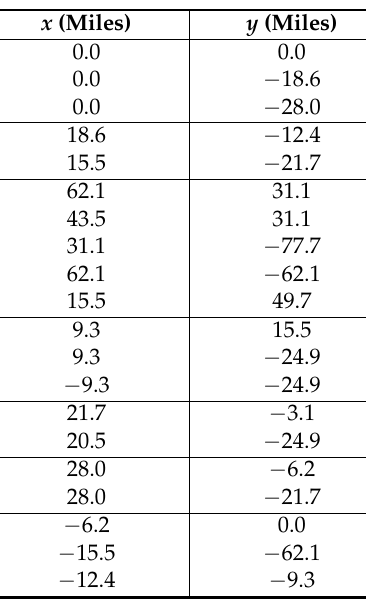
Table 1. Cartesian coordinates of different nodes in the network